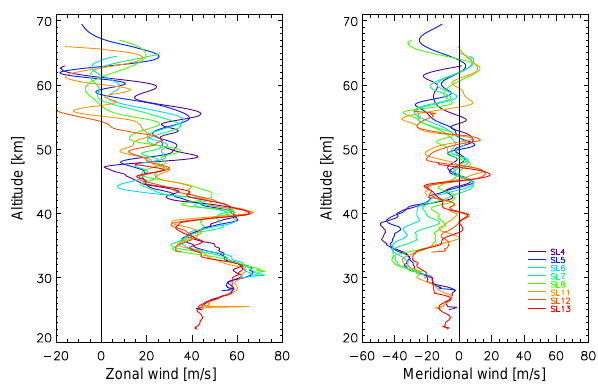
Figure 6. Individual wind profiles measured by datasondes on 14/15 March 2015. The inlet presents the color code of the individual flights. Left: zonal winds, right: meridional